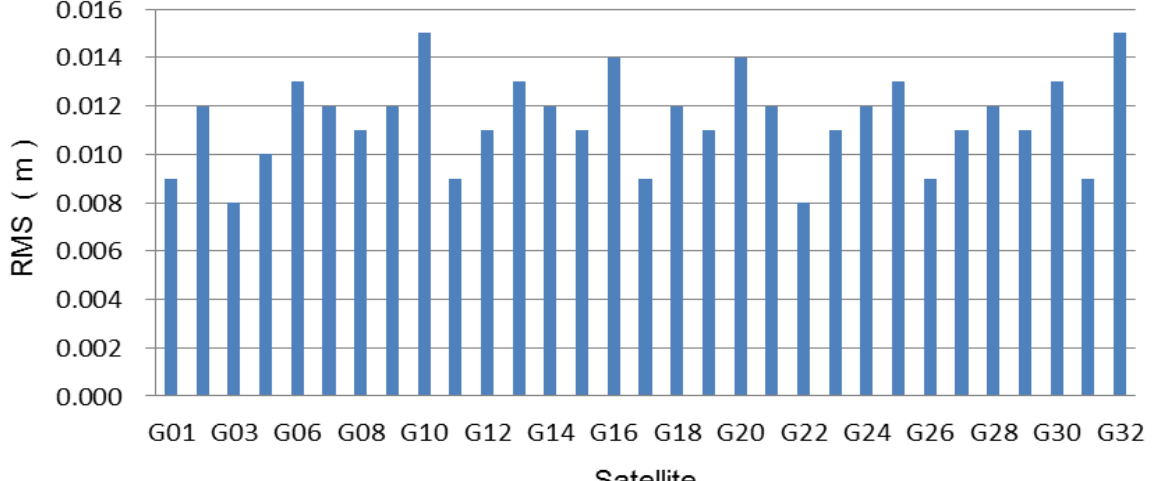
Figure 4. RMSs of the interpolated time-varying ionosphere delays for all tracked satellites.